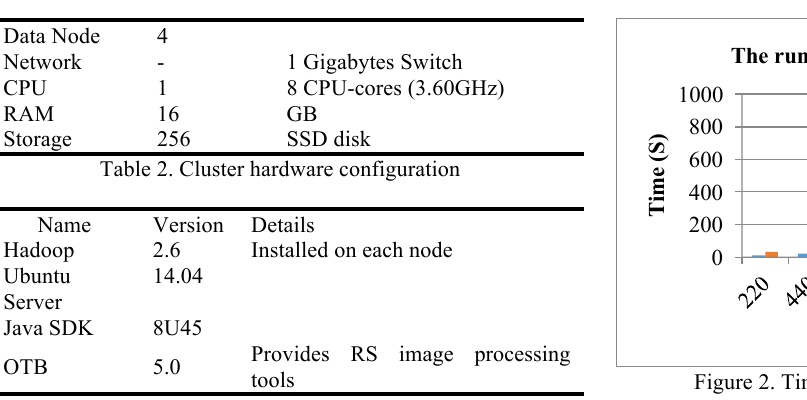
Table 3. Cluster Software Configuration